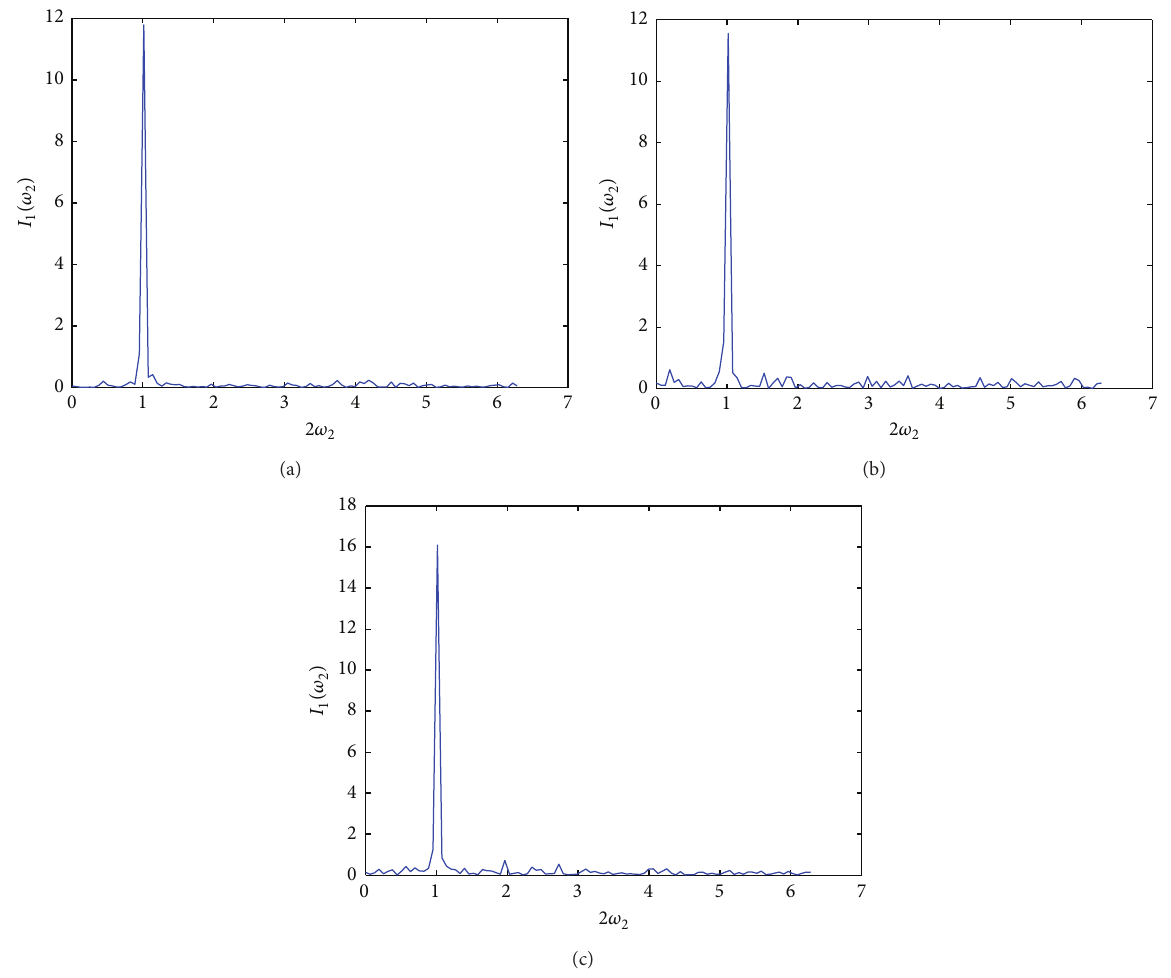
Figure 1: Plot of 𝐼 1 (𝜔 2 ) for Model 1 to Model 3 (from (a) to (c)) with 𝑁 = 100 and 𝜎 2 = 1.5 .